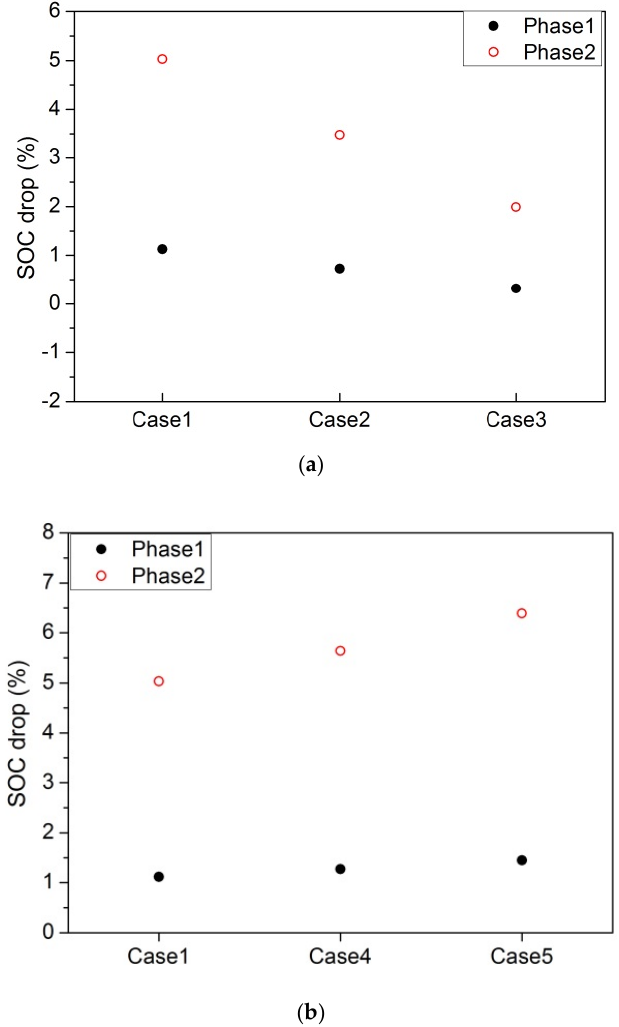
Figure 9. SOC drop in IM240 mode for Phase 1 and Phase 2: ( a ) Reduction in engine torque. ( b ) Reduction in battery capacity.